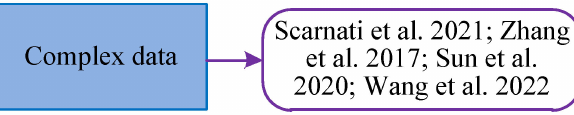
Figure 24. The complex data SAR ATR [174–179].